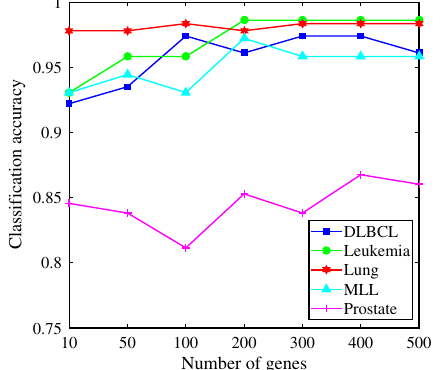
Fig. 2 Classification accuracy via the size of gene subsets on five gene datasets The classification accuracy of selected feature subsets using PTSIJE-FS on 11 datasets is obtained with different neighborhood parameters. For six UCI datasets, the classifi- cation performance is evaluated under two classifiers KNN ( k =10) and CART, which is displayed in Fig. 3a–f, and the classification performance for five gene datasets under three classifiers KNN ( k =10), CART, and C4.5 is illustrated in Fig. 3g–k. The classification accuracy under different parameters λ is shown in Fig. 3, where the abscissa represents different neighborhood parameters λ ∈ [ 0 . 05 , 1 ] , and the ordinate is the classification accuracy. Figure3revealsthattheneighborhoodparametersincrease from 0.05 to 1, and the classification accuracy of features selected by PTSIJE-FS is changing. Different parameters have a certain impact on the classification performance of PTSIJE-FS. Fortunately, every dataset can reach the high result in the wider range of λ . Figure 3a displays that for Credit dataset, the neighborhood parameter will be 0.4 under KNN and 0.1 under CART. From Fig. 3b, for Heart dataset, the neighborhood parameter set 1.0 under classifier KNN and 0.75 under classifier CART, the classification accuracy achieves maximum. In Fig. 3c, for Sonar dataset, the clas- sification performance is at best level when neighborhood parameters are 0.5 and 0.6 under classifiers KNN and CART, respectively. As shown in Fig. 3d, when the neighborhood parameter is set to 0.15 under classifiers KNN and CART, the classification performance is optimal. It can be seen from Fig. 3e that for the Wine dataset, the classification perfor- mance is best when the neighborhood parameter is set to 0.8 under the classifier KNN, and the neighborhood param- eter is set to 0.2 under the classifier CART. From Fig. 3f that on the Wpbc dataset, when the neighborhood parameters are set to 0.15 and 0.3, the classification performance of the selected feature subset under the classifiers KNN and CART reaches the high level at the same time. Figure 3g shows the accuracy of DLBCL dataset and the neighborhood param- eters will be set 0.45, 1.0, and 0.4 under three